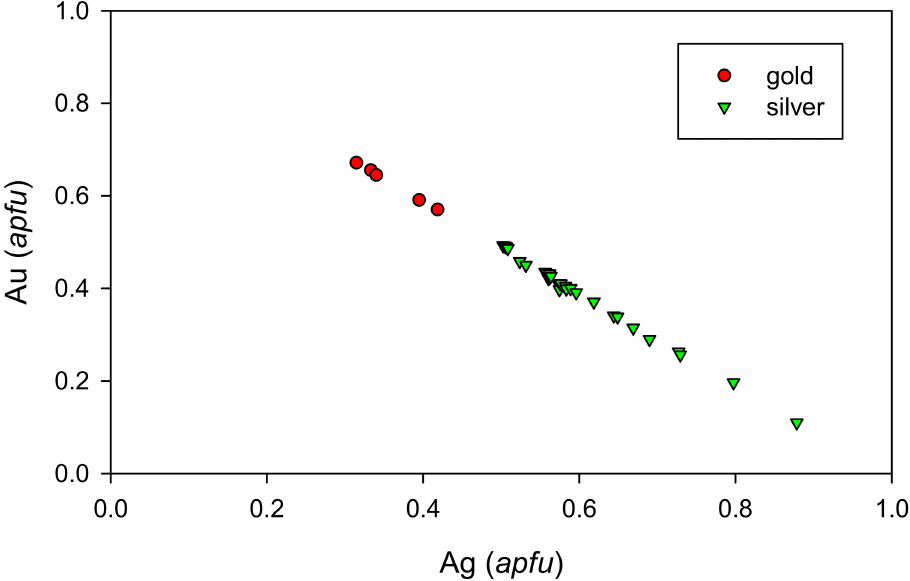
Figure 6. Graph of Ag vs. Au ( apfu ) for members of the Ag–Au solid solution from the Kremnica